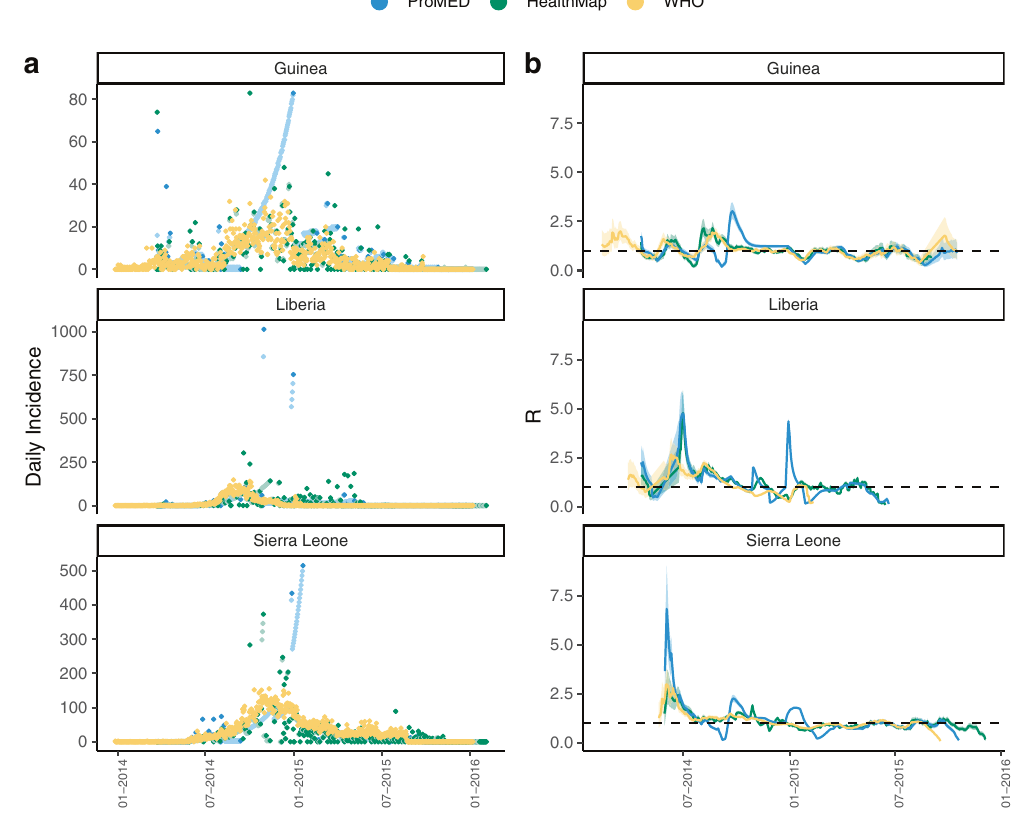
Fig. 1 Comparison of incidence trends and R estimates Comparison of national daily incidence trends and R estimates from ProMED, HealthMap and WHO data for Guinea, Liberia and Sierra Leone. a Daily incidence derived from ProMED (blue), HealthMap (green) and WHO data (orange). Daily incidence that were not directly available from ProMED and HealthMap data and which were therefore imputed (see Methods) are shown in lighter shade of blue and green, respectively. WHO data were aggregated to country level. The y-axis differs for each plot. b The median time-varying reproduction number R t estimated using the WHO data (orange), ProMED (blue) and HealthMap (green) data. The shaded regions depicts the 95% credible intervals (95% CrI) for the R t estimates. The reproduction number was estimated on sliding windows of 28 days with a Gamma prior with mean 1 and variance 0.25, using the R package EpiEstim 26 . Estimates shown at time t are for the 28-day window fi nishing on day t